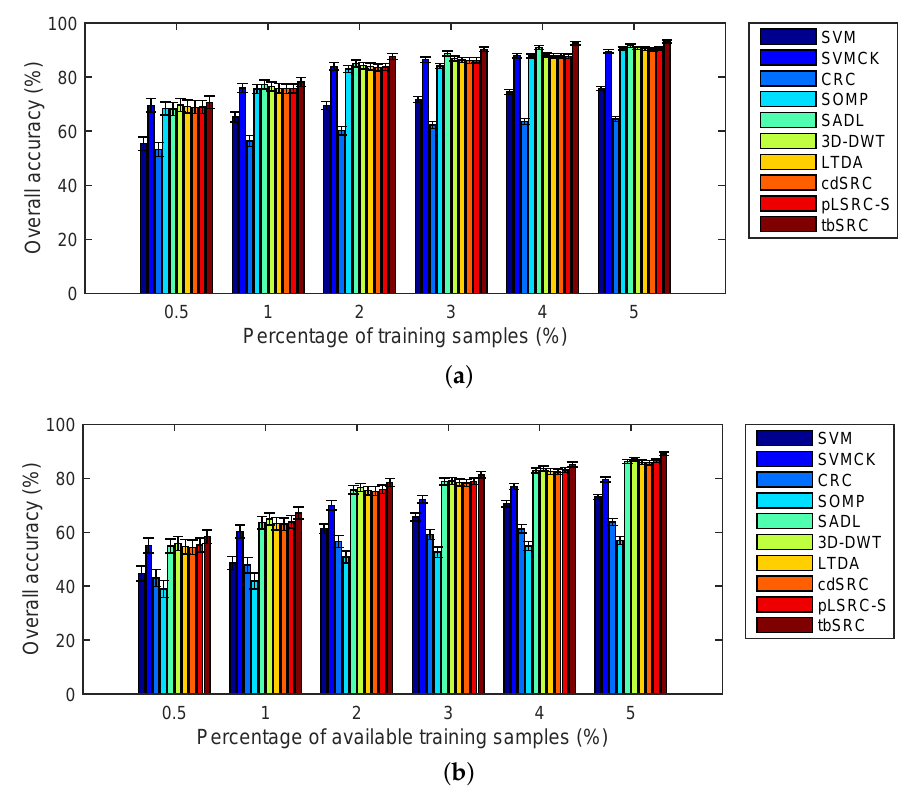
Figure 12. Overall accuracy (%) of different methods with various numbers of labeled samples for ( a ) Indian Pines data and ( b ) University of Pavia